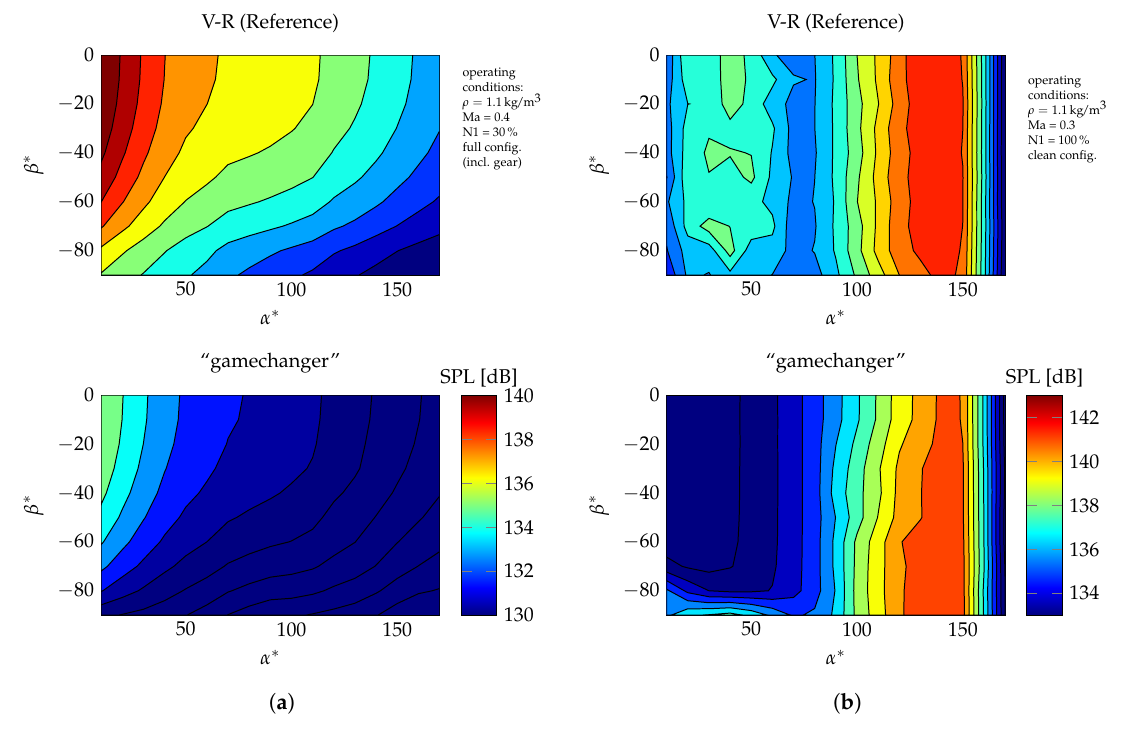
Figure 13. Emission diagrams of V-R and “gamechanger” for departure and approach configurations. ( a ) Emission diagrams—approach configuration. ( b ) Emission diagrams—departure